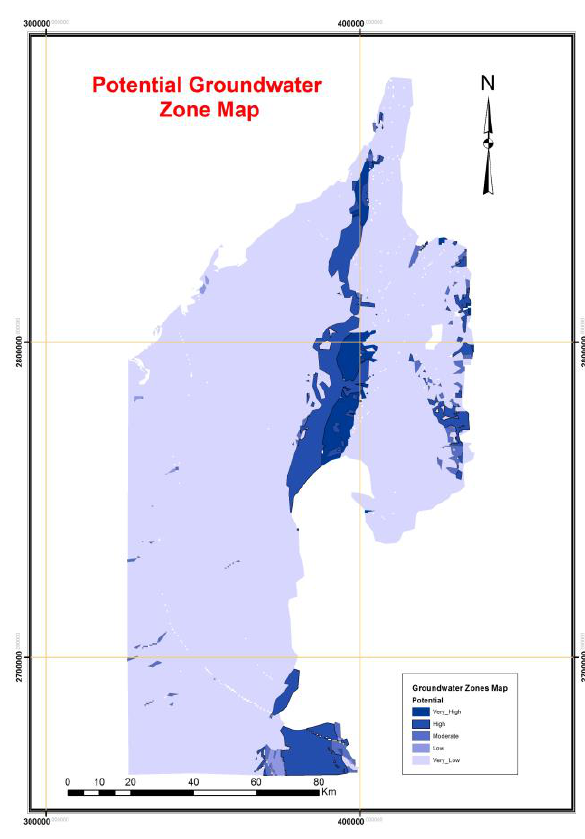
Figure 6. Potential Groundwater zone